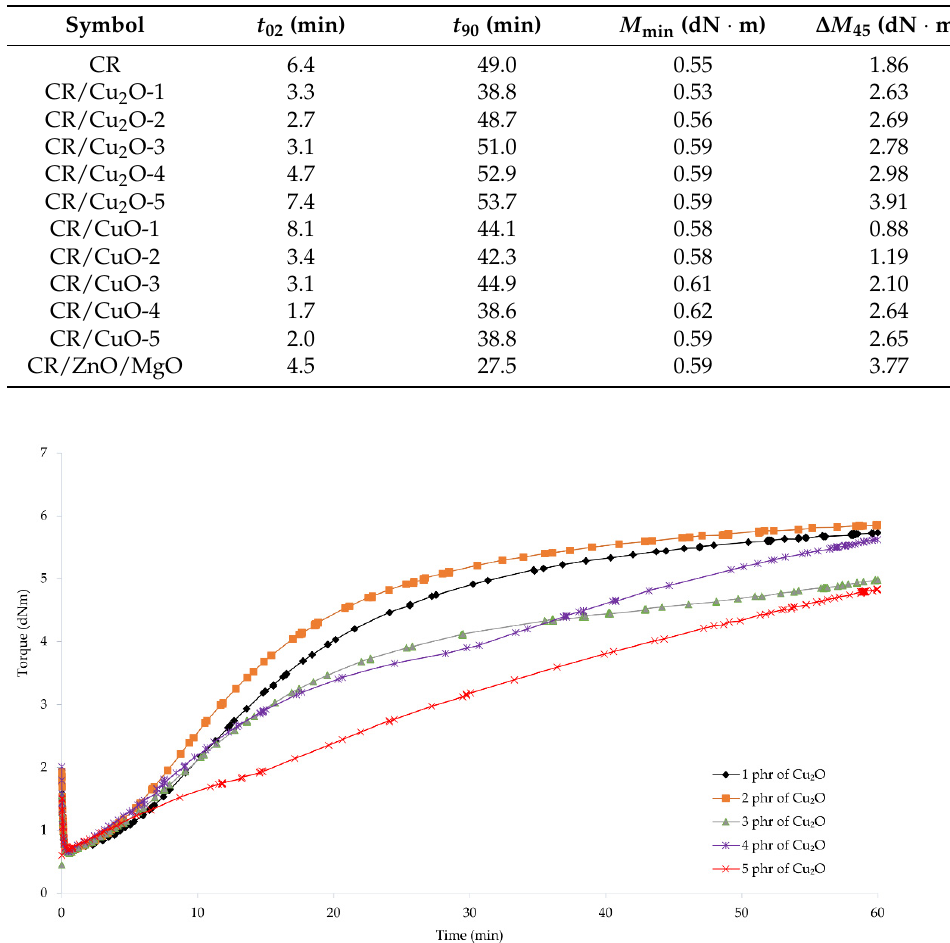
Figure 1. Vulcametric kinetics of chloroprene rubber cross-linked with copper(I) oxide (1–5 phr of Cu 2 O).